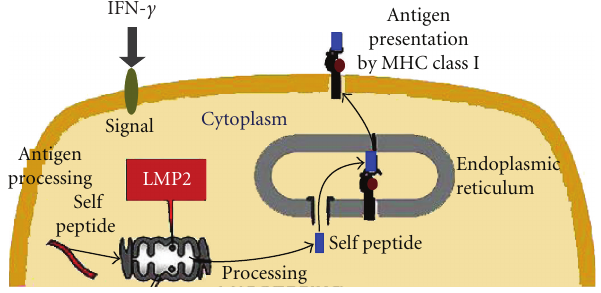
Figure 1: Mediation of the proteasomal degradation pathway to antigen presentation by MHC class I. The immunoproteasomal degradation pathway is essential for antigen presentation by MHC class I. Defecive LMP2 expression results in tissue- and substrate- dependent abnormalities of immunoproteasomalfunctions. There- fore an impaired proteasome may promote the initial development of disease including